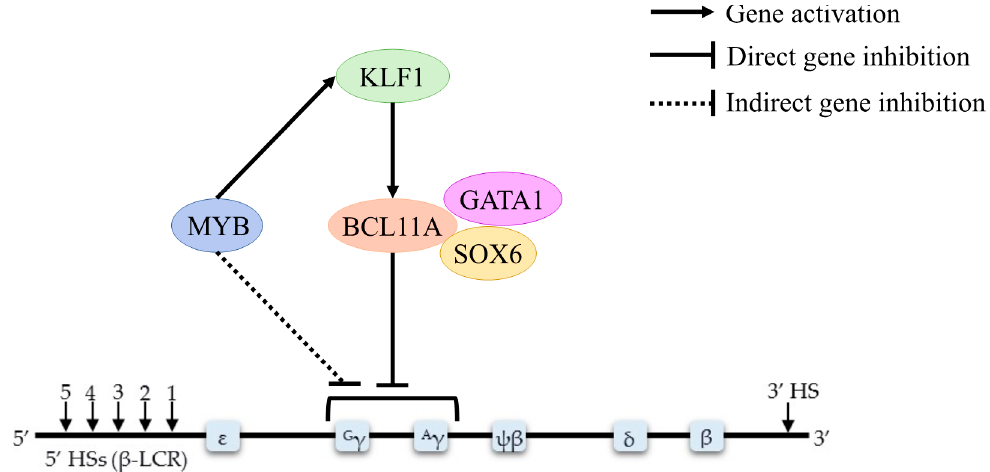
Figure 3. Regulators of the γ –globin gene, potentially inducing HbF production. BCL11A acts as a γ –globin silencer, and it is positively regulated by KLF1 . MYB indirectly modulates HbF expression through the alteration of erythroid differentiation kinetics, and MYB also directly activates KLF1 and other